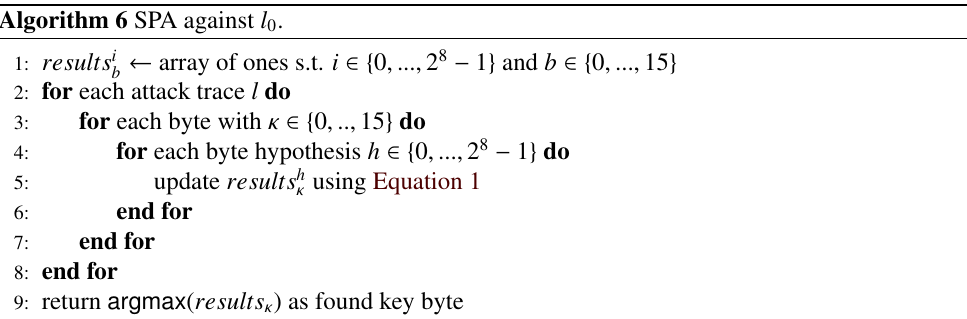
Algorithm 6 SPA against l 0 .